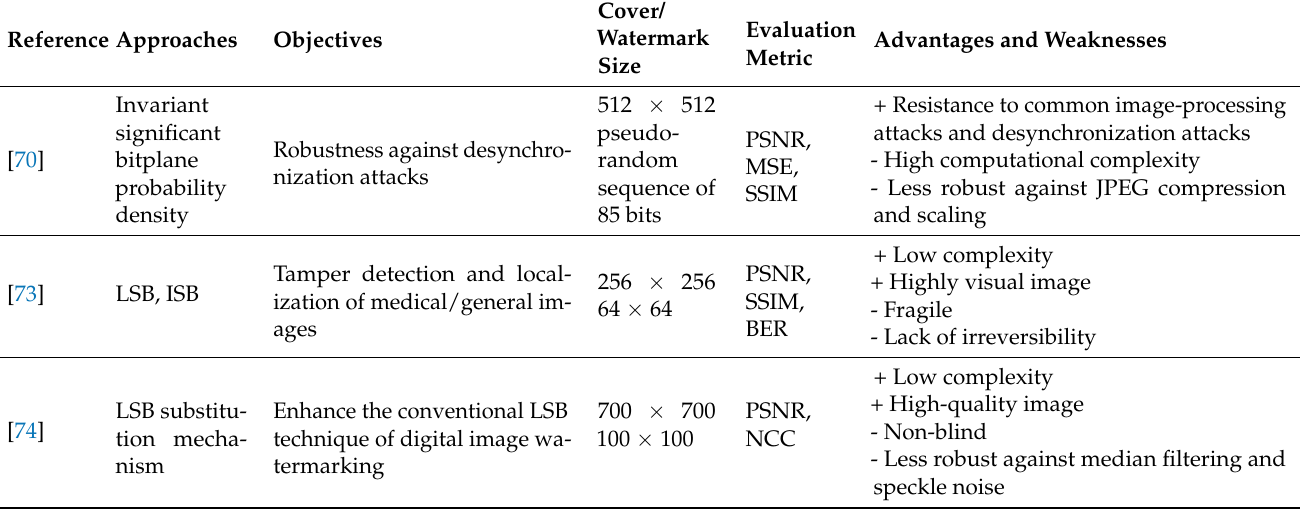
Table 1. Summary of spatial domain-based image watermarking